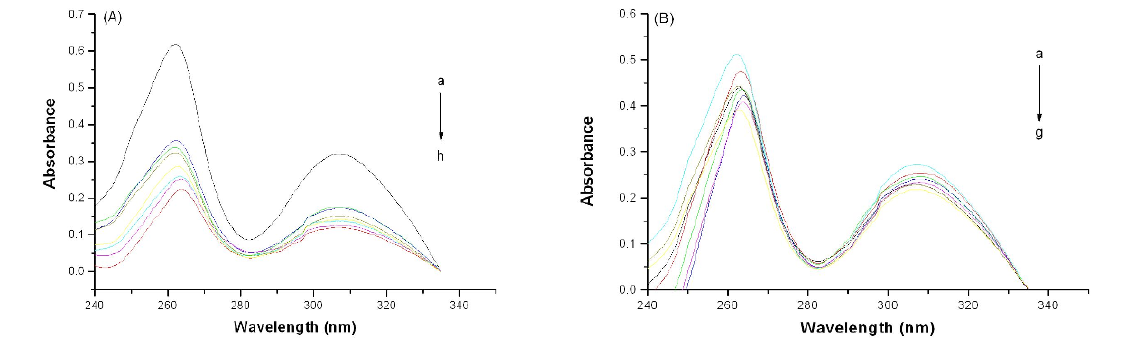
Figure 2. Electronic spectra of karanjin (6.7×10 -5 M) in the absence (a) and the presence of 1 µM (b), 5 µM (c), 10 µM (d), 15 µML (e), 20 µM (f), 25 µM (g), 30 µM (h) DNA at pH 7.4 (A) and 4.7 (B) and at 37ºC. The direction of arrow indicates addition of DNA